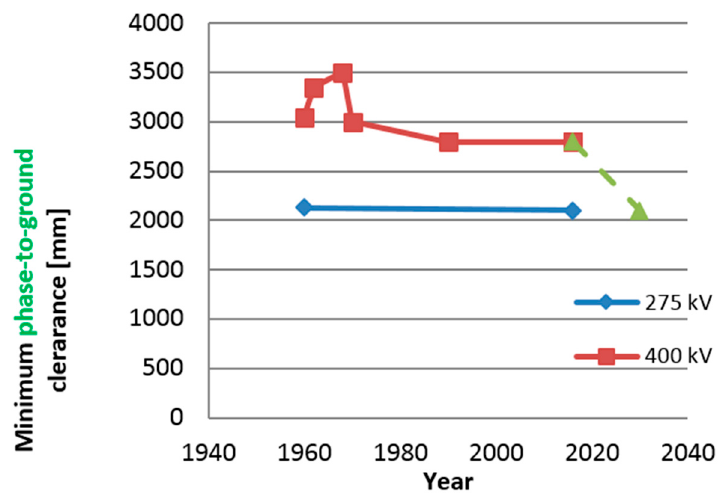
Figure 1. Evolution of UK HV minimum clearances and the proposed one [7].